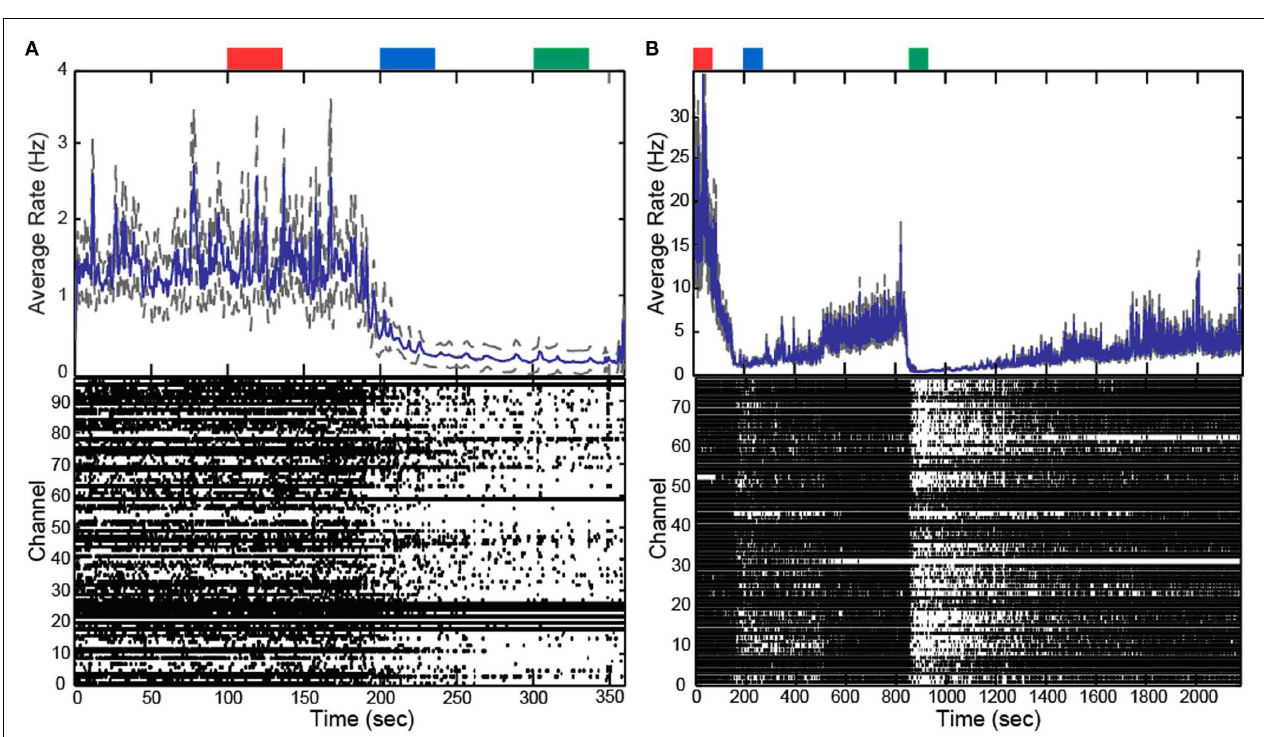
errors wide centered at the mean. Colored rectangles above the plots correspond with time periods chosen for the average firing rate calculations. Red represents the baseline or awake state. Blue represents the lightly anesthetized state. Green represents the deeply anesthetized state.With the emergence from anesthesia, the firing rate begins to increase in Feline A after both boluses of propofol.